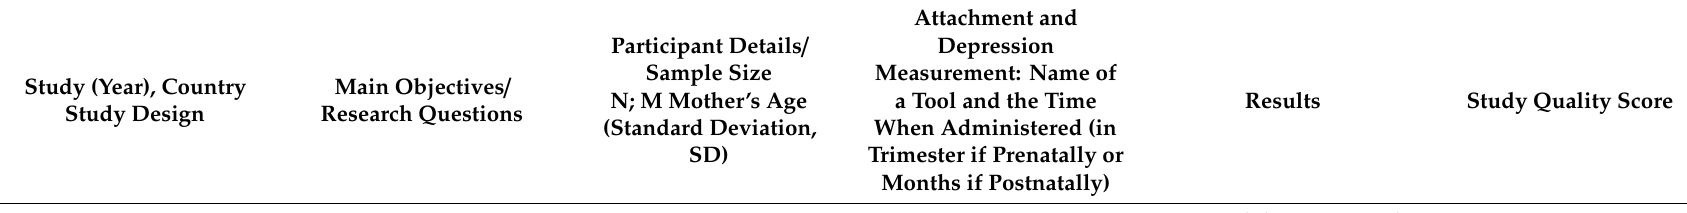
Table 2. Details of the reviewed studies measuring the impact of maternal depression on attachment security; all used self-report questionnaires to diagnose depression.